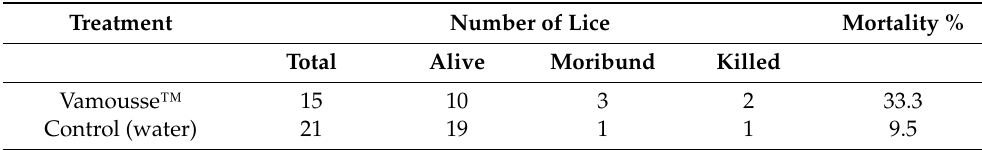
Table 2. Effect of Vamousse™ on head lice recorded 18 h after treatment.